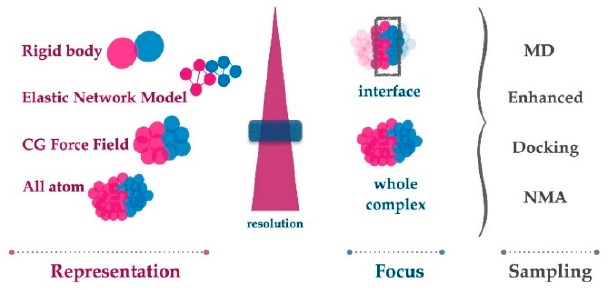
Figure 1. The accurate modeling of protein interface dynamics relies on three choices: system representation, system focus, and the sampling algorithm. If the level of information is sought at the atomic scale, then all atom representation should be selected. Depending on the resources that can be invested, the dynamics of the whole complex or only the interface could be chosen as the focus. In such a situation, classical MD would generate the finest level of sampling. Though, for bigger systems or shorter computing times, faster enhanced sampling methods could be used. If larger-scale motions are expected, then coarse grain (CG) force fields or elastic network models could be used as system representations. Those can be sampled with any of the sampling methods listed. Finally, in case the binding mechanism is investigated, rigid body minimization driven docking could deliver several solutions that could represent encounter complex formation. This solution set could also tell us how different solutions in a well-defined interface can fluctuate, thus indirectly reporting on the interface dynamics.